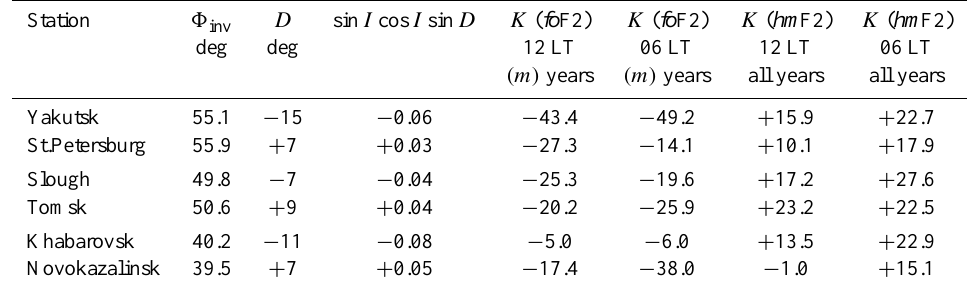
Table 3. Annual mean slope K (in 10 − 4 per year) for the period after 1965 for the stations with close 8 inv , but different D . Years of solar minimum (m) for fo F2 and all years for hm F2 trend analysis are used. Station 8 inv D sin I cos I sin D K ( fo F2) K ( fo F2) K ( hm F2) K ( hm F2) deg deg 12 LT 06 LT 12 LT 06 LT (m) years (m) years all years all years 55.1 − 15 − 0.06 −